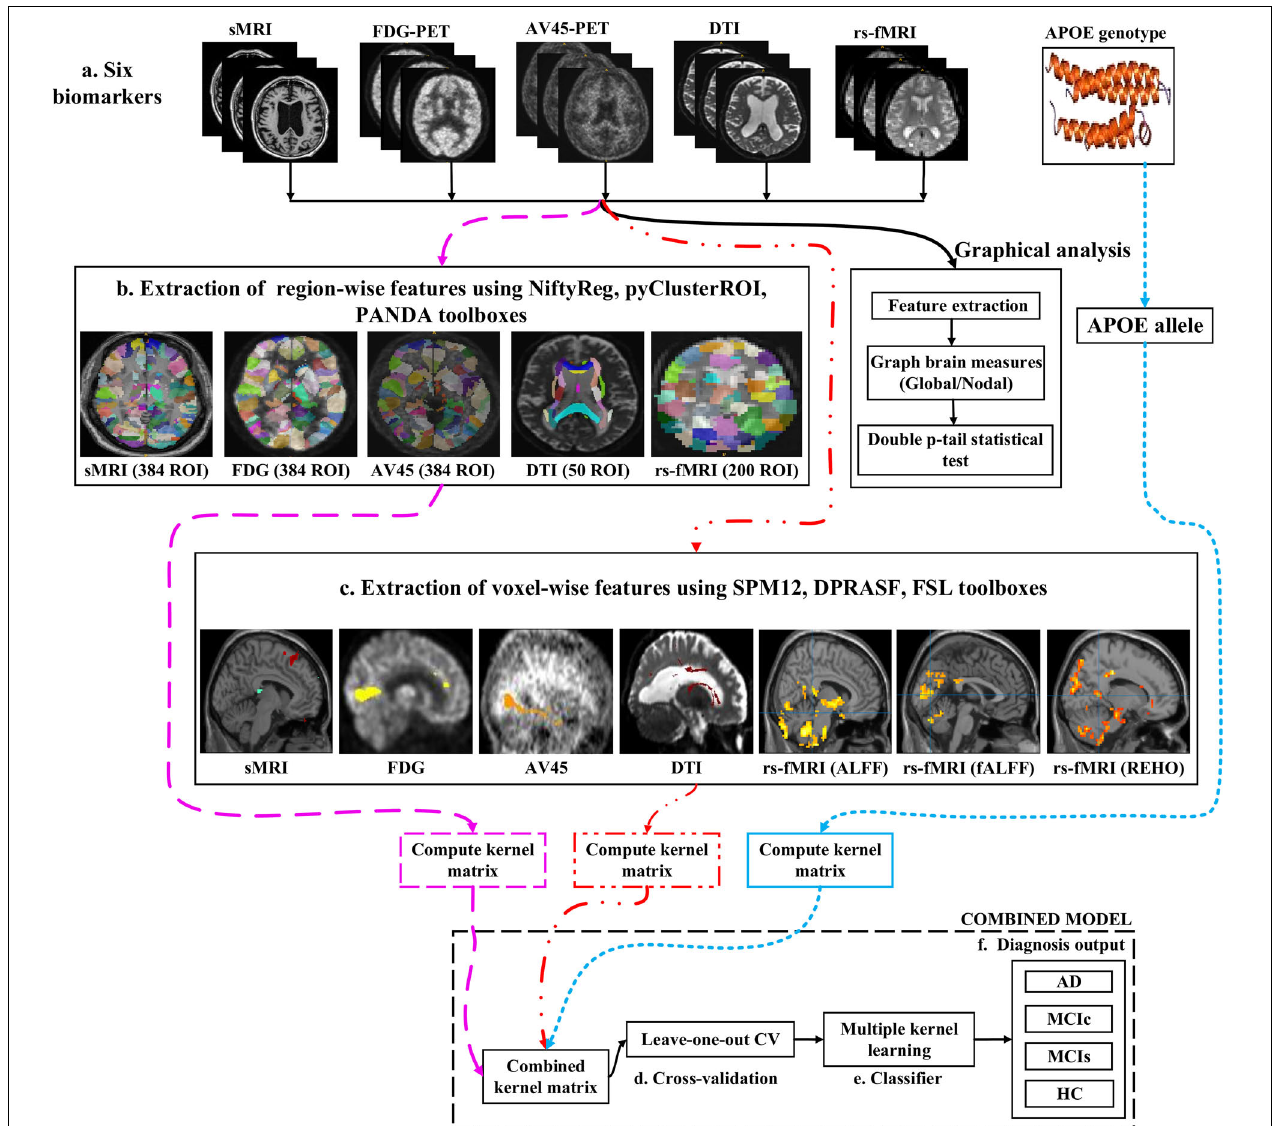
FIGURE 1 | Overview of the multimodal framework. (A) Selection of five imaging modalities (sMRI, FDG-PET, AV45-PET, rs-fMRI, and DTI) and APOE genotype. (B) Extraction of regional features using NiftyReg, pyClusterROI, and PANDA toolboxes. (C) Extraction of voxel features using SPM12, DPARSF, and FSL toolboxes. (D) Leave-one-out cross-validation method. (E) Multiple kernel learning. (F) Diagnostic